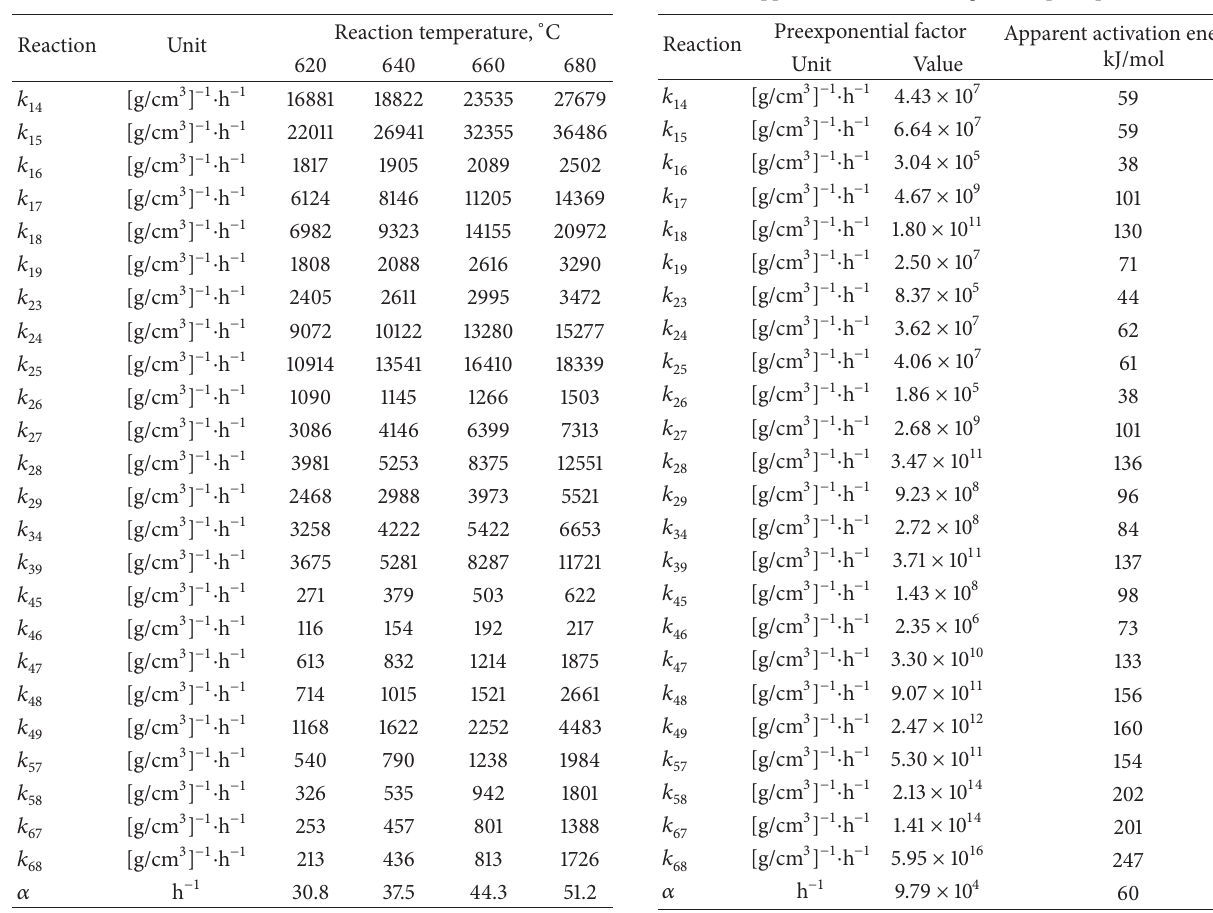
Table 4: Calculated kinetic constants. Table 5: Apparent activation energies and preexponential